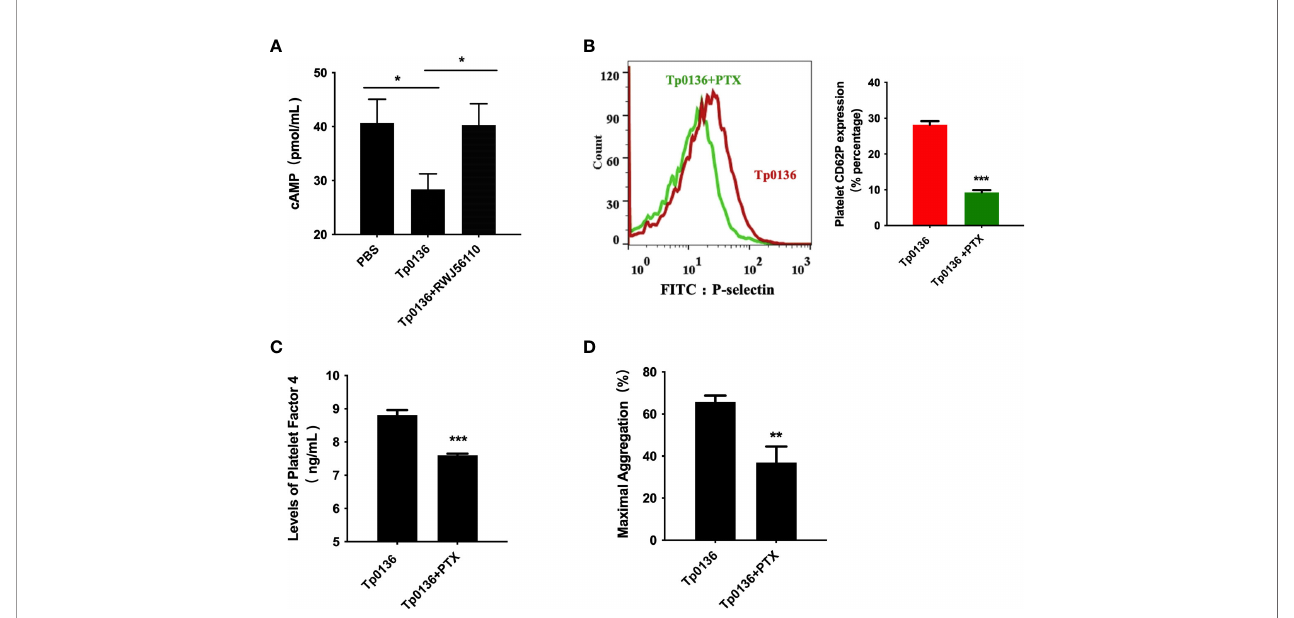
FIGURE 5 | Tp0136 enhanced G i signaling through PAR1 during platelet activation. (A) cAMP as analyzed by ELISA. (B) P-selectin as measured by fl ow cytometry. A representative histogram is shown. (C) PF4 as measured by ELISA. (D) Maximal platelet aggregation as determined by an aggregometer. The values are presented as the mean ± SEM of experimental triplicates and are representative of the results of three independent experiments. Comparisons between the two groups were analyzed using a paired t-test (* P < 0.05, ** P < 0.01, *** P <